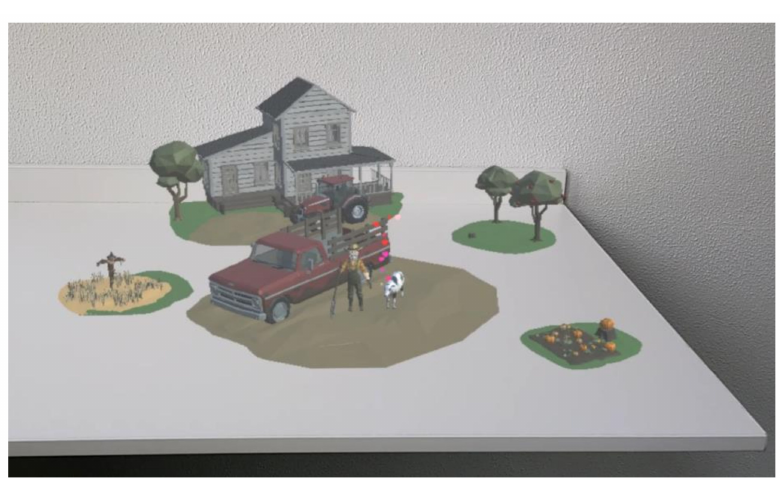
Figure 3. Sample impression Act